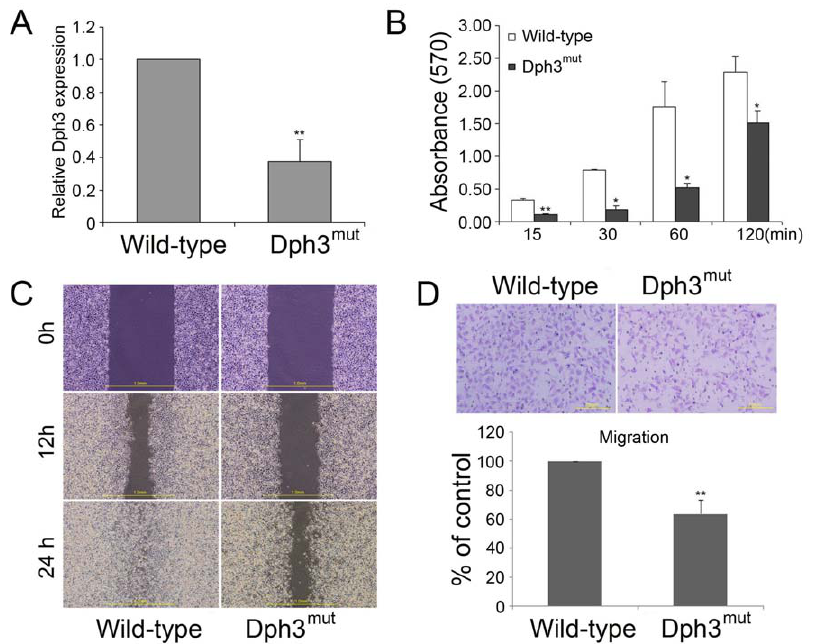
Figure 1. Identification of a novel role of Dph3 in the metastasis of melanoma B16F10 cells. A, Dph3 expression in Dph3 mut cells was analyzed by real-time PCR. B, a total of 1 6 10 5 cells were seeded into pre-treated 96-well plates for the indicated times. Attached cells were stained with crystal violet and measured spectrophotometrically. Results are expressed as absorbance values. C, wound healing of control and Dph3 mut cells was performed and representative pictures of the wound distance were taken at each time point as indicated. Scale bars: 1 mm. D, the cell motility was evaluated by transwell assays. Representative pictures were taken after staining with crystal violet. Scale bars: 200 m m. Data are collected from three independent experiments and are average 6 S.E. values. * p , 0.05, ** p , 0.01, compared to wild type cells.